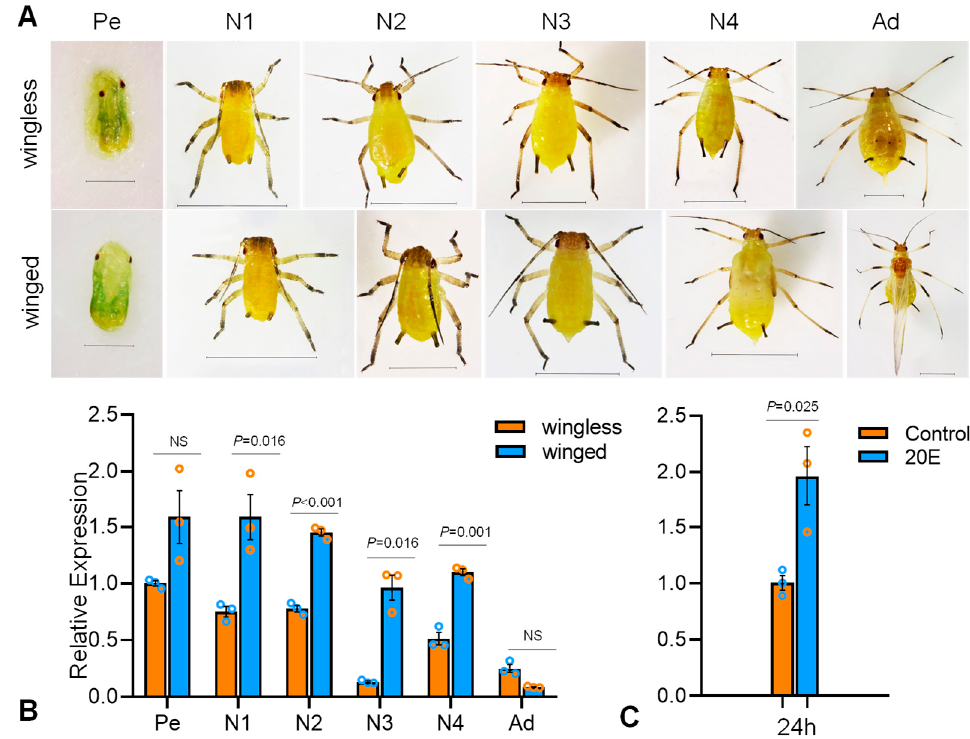
Figure 3. Temporal dynamics of SaE75 . ( A ) Developmental profiles of two morphs of S. avenae . Relative abundance of SaE75 on ( B ) different developmental stages and ( C ) 20E treatment were validated using RT-qPCR. Pe: pseudo embryo; N1: nymph 1; N2: nymph 2; N3: nymph 3; N4: nymph 4; Ad: adult; Scale bar: 20 µ m for Pe; 100 µ m for N1-Ad. Different color circle represents three replications of experiment. Error bars represent means ± SD. Data were normalized with respect to helicase ( HEL ), and bar graphs were fit to the data using GraphPad Prism (v8.0.1). The p values indicate significant differences, and NS means not significant.